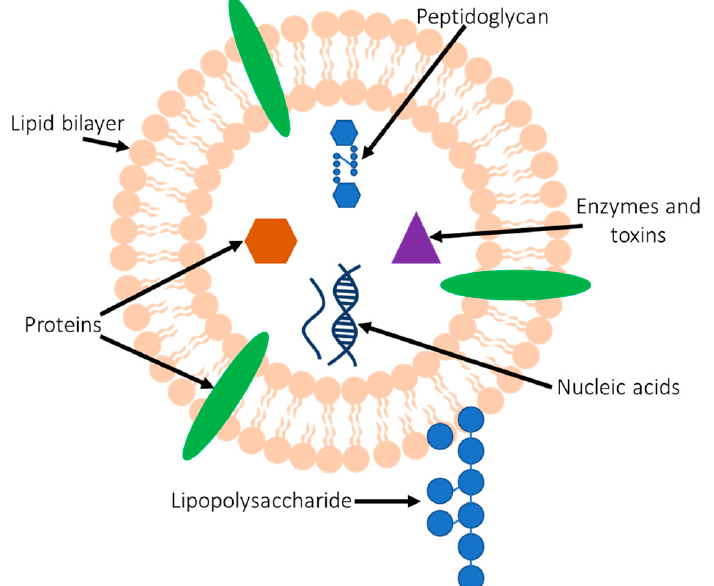
Figure 1. Schematic of a bacterial membrane vesicle. Bacterial membrane vesicles (BMVs), which includes outer membrane vesicles (OMVs) produced by Gram-negative bacteria and membrane vesicles (MVs) produced by Gram-positive bacteria, are nanoparticles produced by all bacteria as part of their normal growth. BMVs contain a range of immunostimulatory microbe-associated molecular patterns (MAMPs) from their parent bacterium, such as peptidoglycan, lipopolysaccharide, DNA and RNA, in addition to bacterial specific virulence determinants such as toxins and enzymes that can mediate the induction of an inflammatory response and promote disease in the host. The contribution of BMVs to mediating pathogenesis and modulating immunity is well established. BMVs have been observed within a range of tissues and biopsies and cerebral spinal fluid, indicating their clinical relevance to mediating pathology